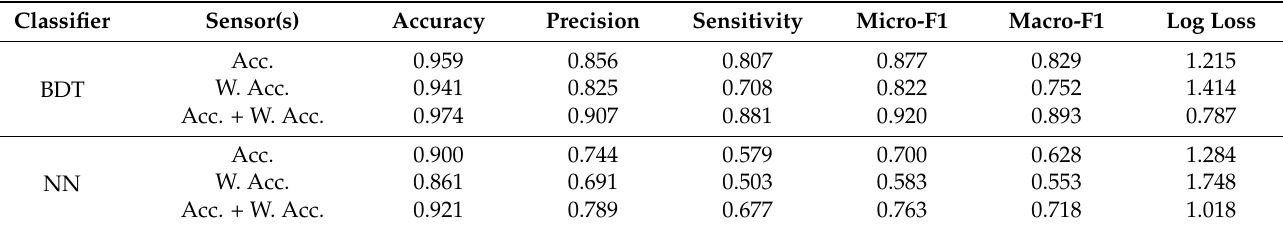
Table 4. Average results for primary physical activity recognition